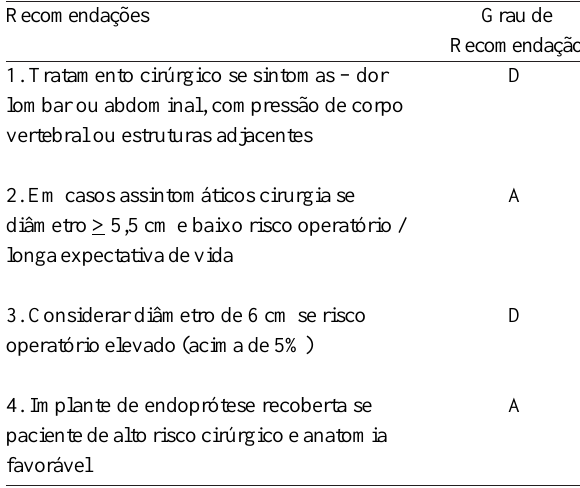
Tabela 1. Critérios de intervenção nos Aneurismas Aórticos Infra-